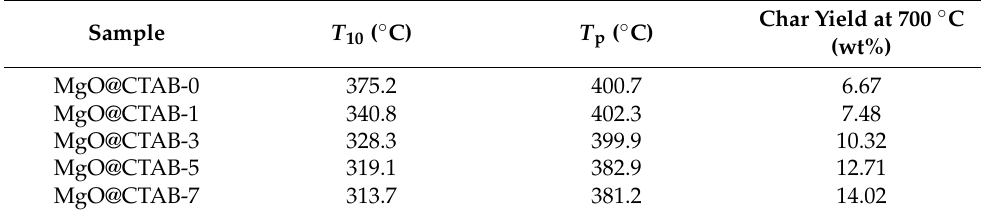
Figure 6. TGA curves of PBAT/MgO@CTAB nanocomposites. ( a ) TGA, ( b ) DTG. Table 2. Thermal stability of PBAT and its nanocomposites. Table 2. Thermal stability of PBAT and its nanocomposites.